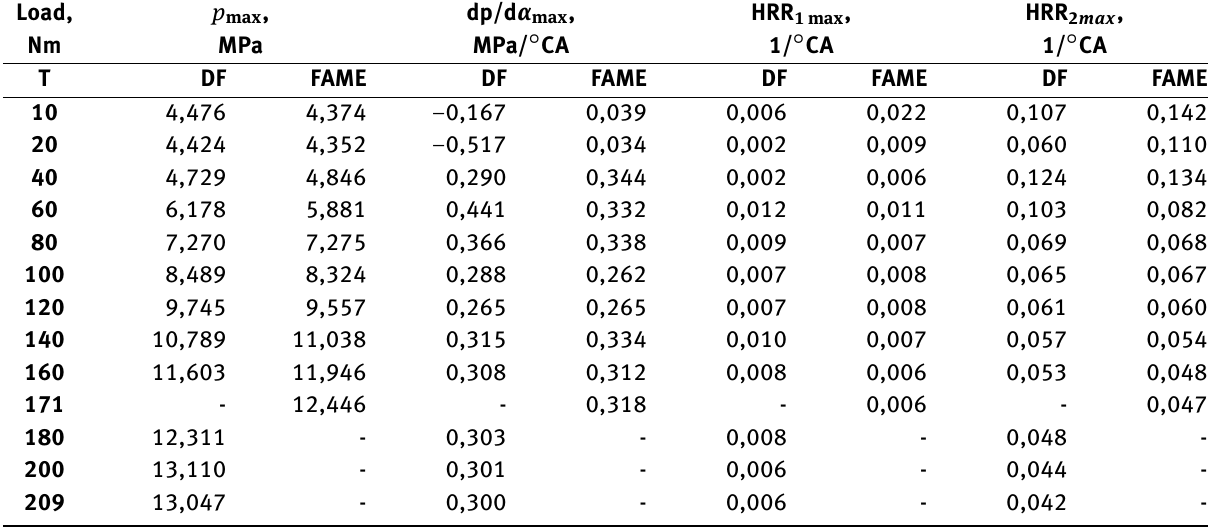
Table 3: The maximum combustion process pressure values p max , maximum pressure increase rate in the cylinder ( dp / dα ) max and max-